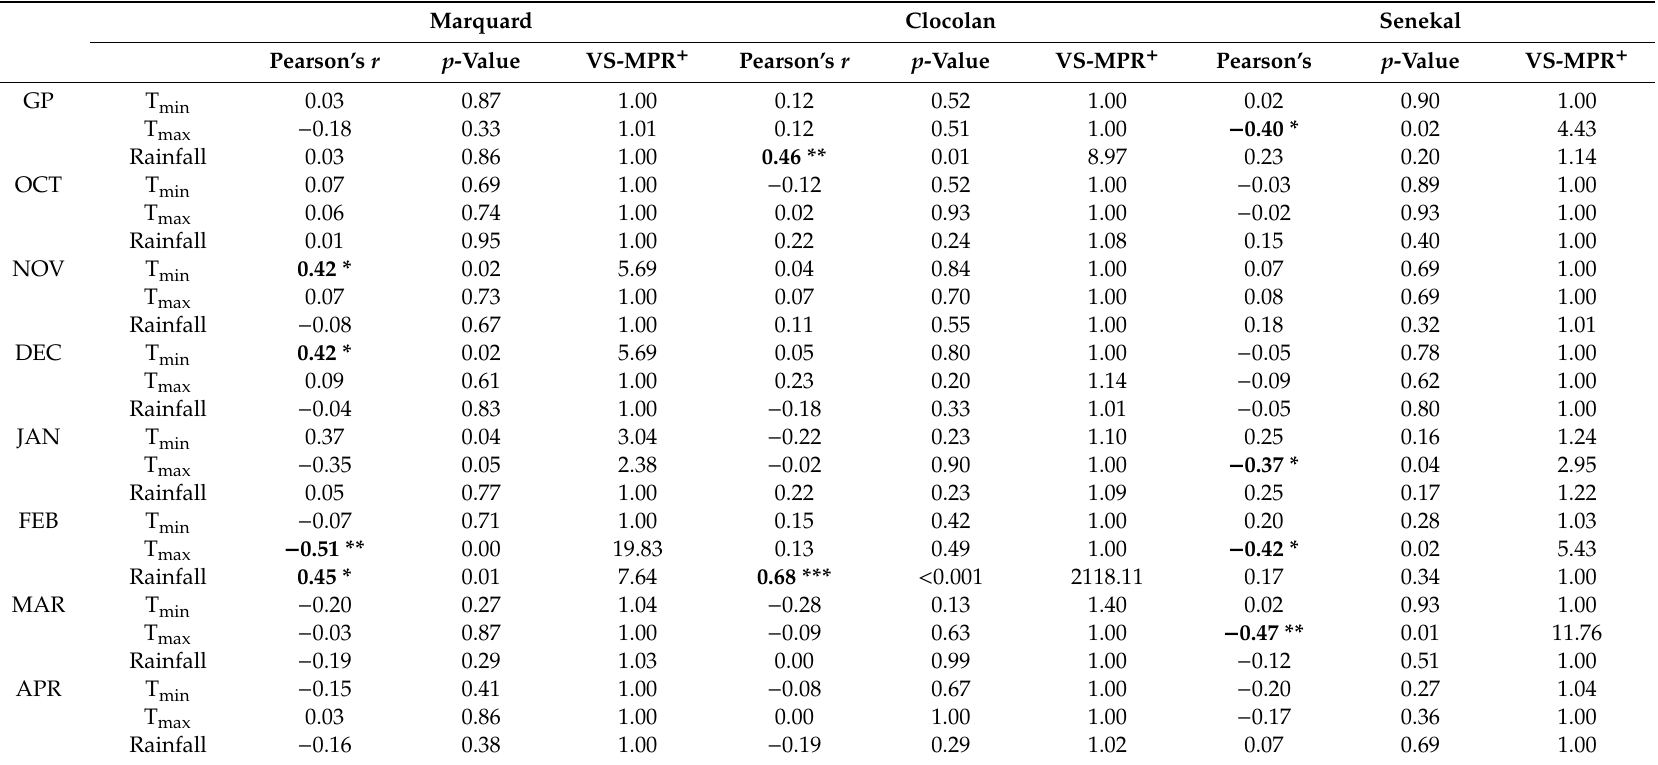
Table 9. The correlation matrix for the monthly and growing period T min , T max and Rainfall variables with Maize yield in the three stations (the fourth station, Ficksburg, lacks su ffi cient data for analysis) of the Setsoto municipality from 1985–2016 (* p < 0.05, ** p < 0.01, *** p < 0.001). GP denotes growing